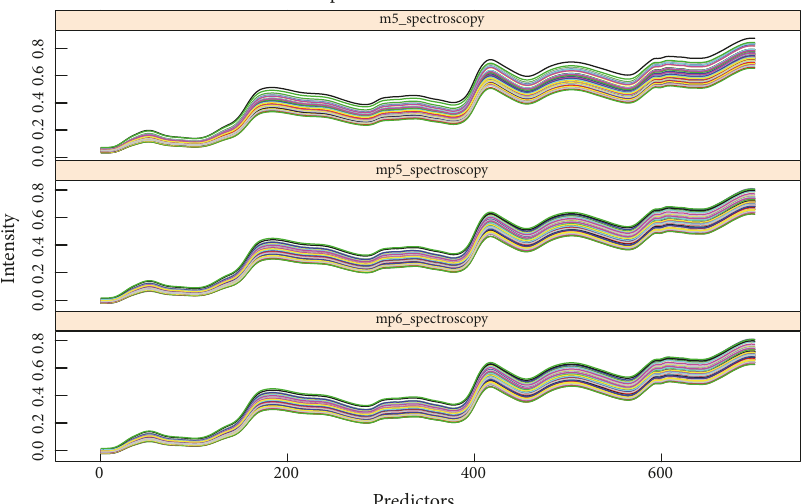
Figure 4: The intensity of each wavelength under three predictor matrices called “m5spec”, “mp5spec”, and “mp6spec” from corn data set. Most of predictors are highly correlated.